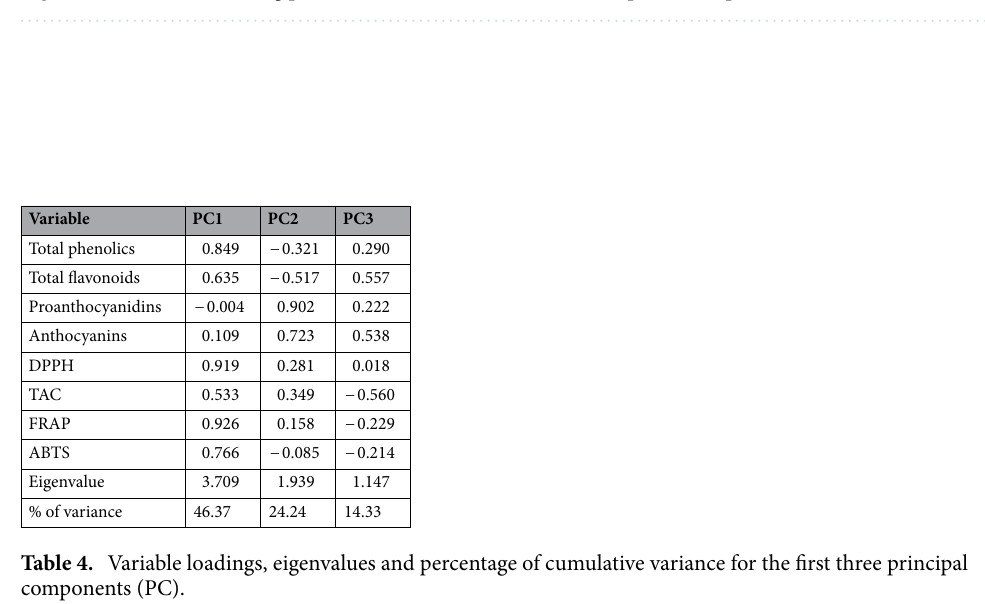
Figure 2. ( a ) Factors loading plot on PC1xPC2xPC3 and ( b ) scores plot of samples.